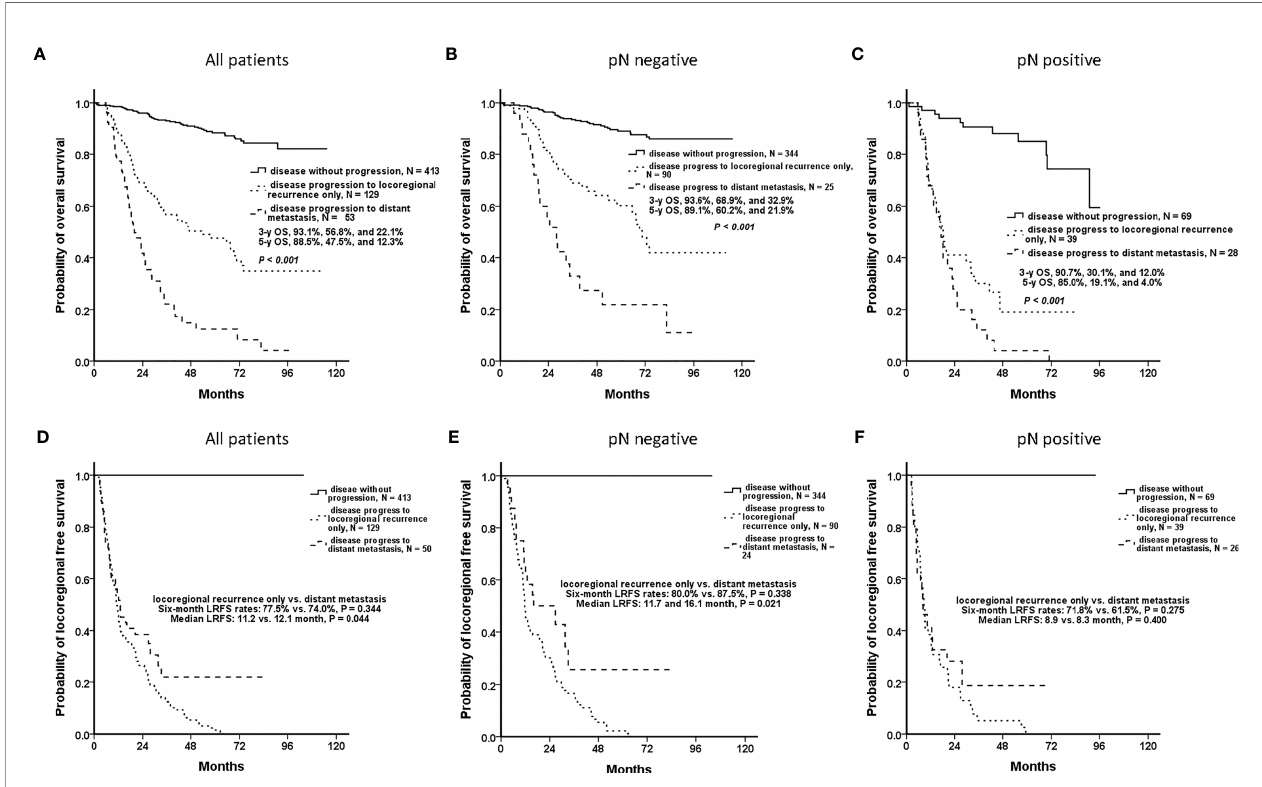
FIGURE 2 | Clinical outcomes of patients who were disease-free, had locoregional recurrence only, and had distant metastasis (DM) with any locoregional status. In accordance with disease progression patterns, the patients were classi fi ed as those who were disease-free (without disease progression), who had locoregional recurrence only, and had DM with any locoregional status. (A) Overall, the patients who had DM had signi fi cantly worsened overall survival (OS) than did the others ( P <.001). (B, C) In both the nodal-negative and -positive groups, the patients who developed DM had signi fi cantly poorer OS than those of the patients without DM. (D) The patients who developed locoregional recurrence only and DM with any locoregional status had similar 6-mo locoregional recurrence-free survival (LRFS) rates (77.5% and 74.0%, respectively, P = .344). It was dif fi cult to differentiate both disease patterns at the early phase. (E) For the nodal-negative group, the 6-mo LRFS rates of the patients who developed locoregional recurrence only and who had DM were 80.0% and 87.5%, respectively ( P = .338), and the median LRFS periods were 11.7 and 16.1 mo, respectively ( P = .021). (F) For the nodal-positive group, the 6-mo LRFS rates were 71.8% and 61.5%, respectively ( P = .275), and the median LRFS periods were 8.9 and 8.3 mo, respectively ( P =